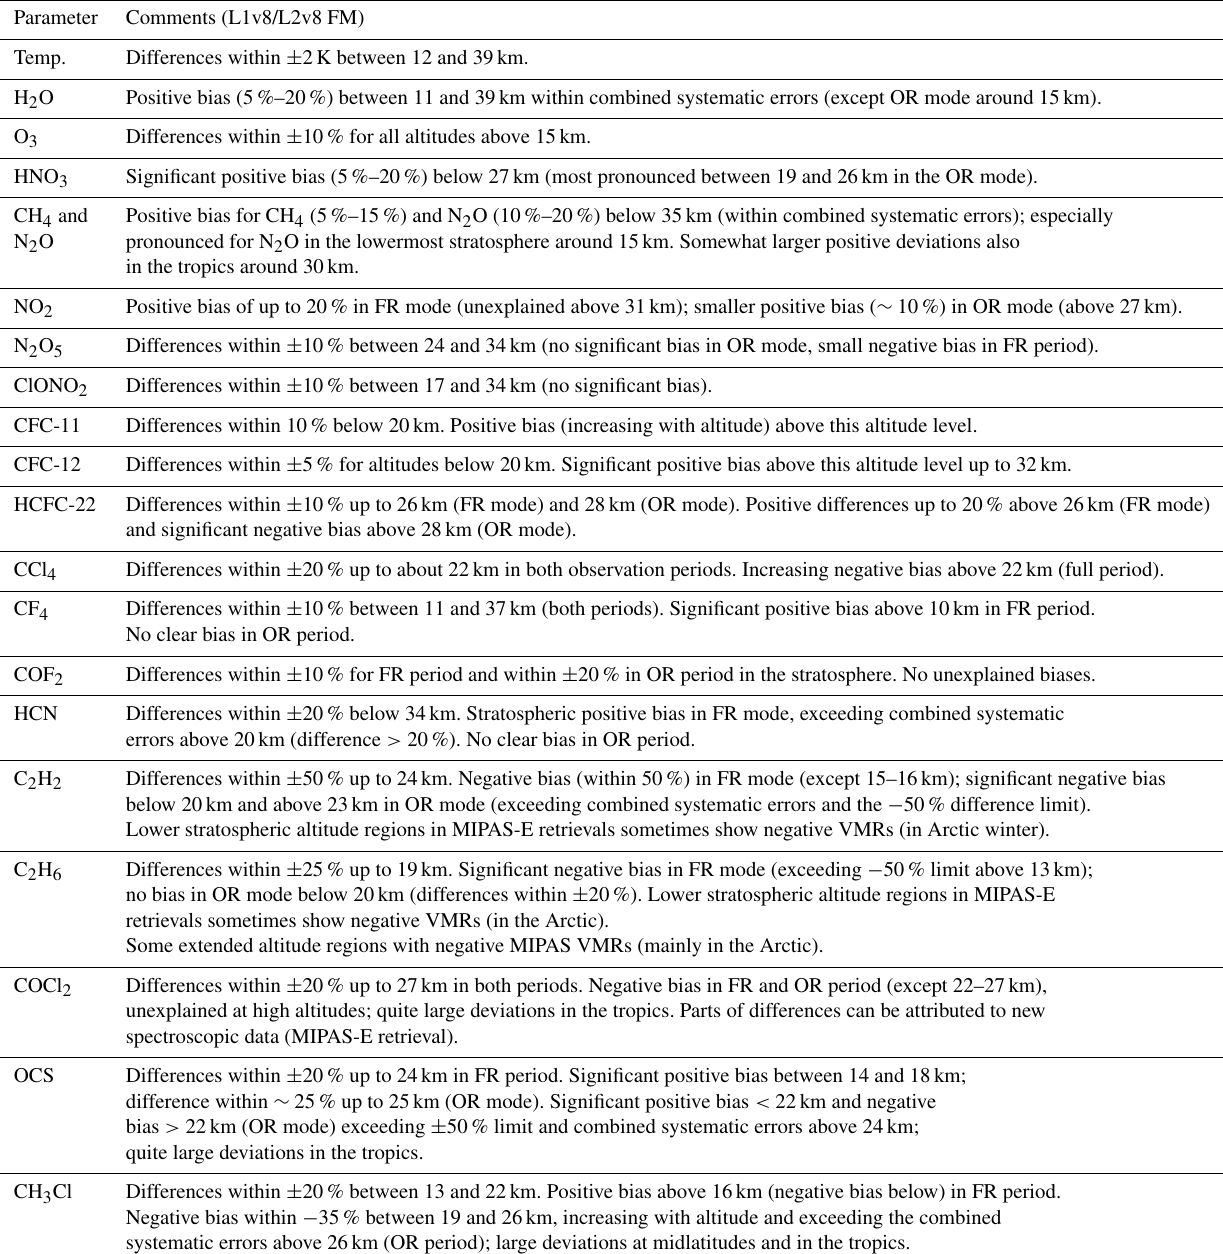
Table 4. Summary of MIPAS-E validation results (trajectory comparison to eight MIPAS-B flights). Mentioned atmospheric parameter differences refer to MIPAS-E minus the balloon